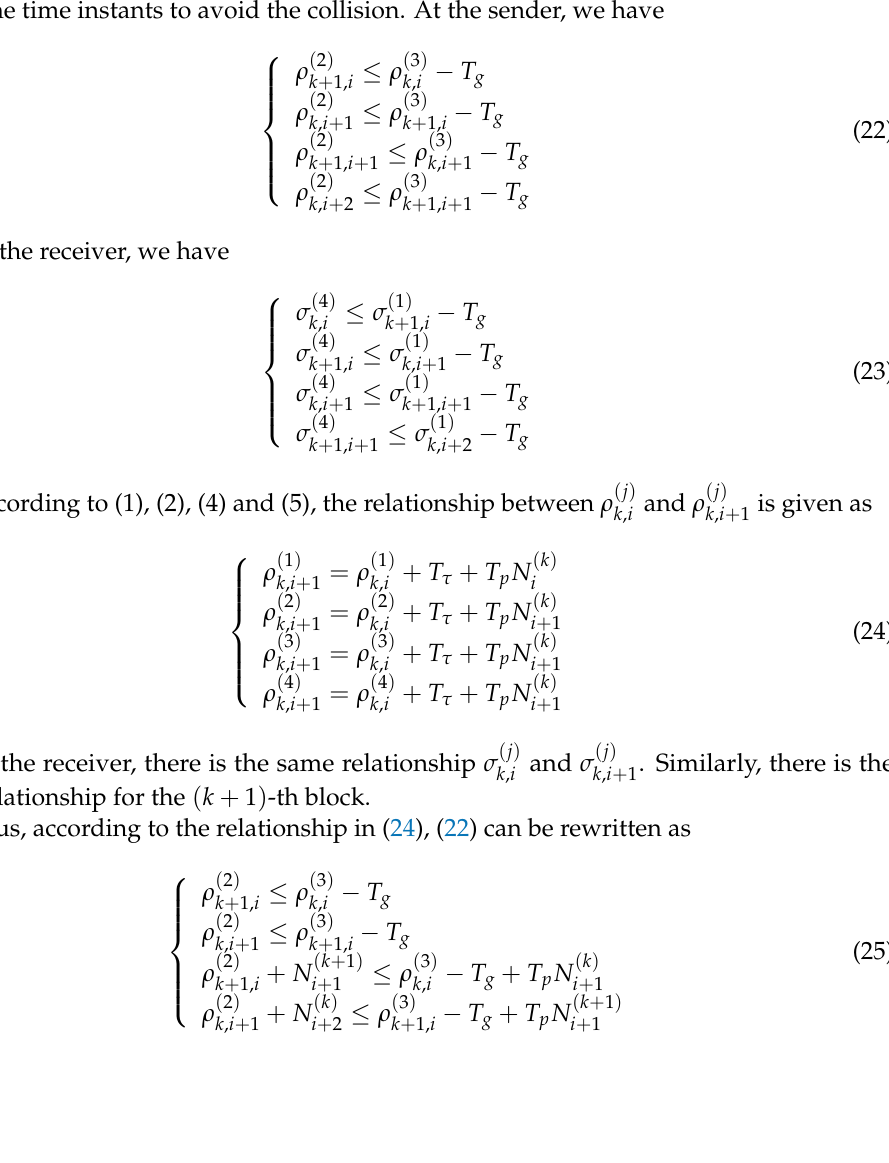
Figure 2. The proposed RLPC-J-ARQ scheme. ( j ) ( j ) In Figure 2, ρ and σ represent the time points for the sender and receiver with k + 1, i k + 1, i the ( k + 1 ) -th block, respectively. The relationship between the time instants ρ ( j ) σ are similar to those of the k -th block. According to Figure 2, there are some k + 1, i